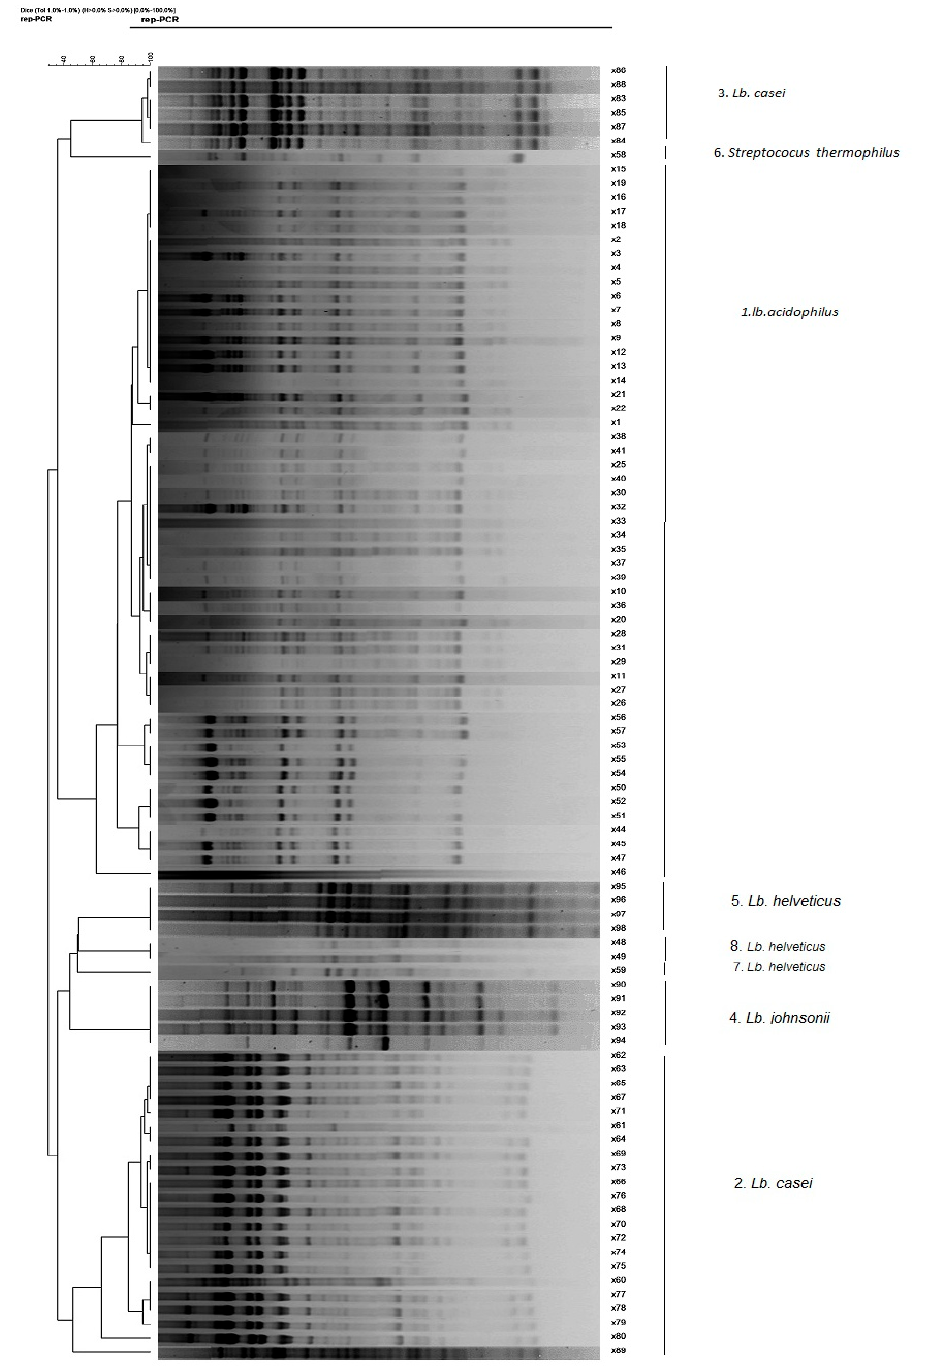
Figure 3. Dendrogram generated after cluster analysis of rep-PCR fingerprints of tested isolates. The ruler on the top left corner of the image indicates the similarity percentage .